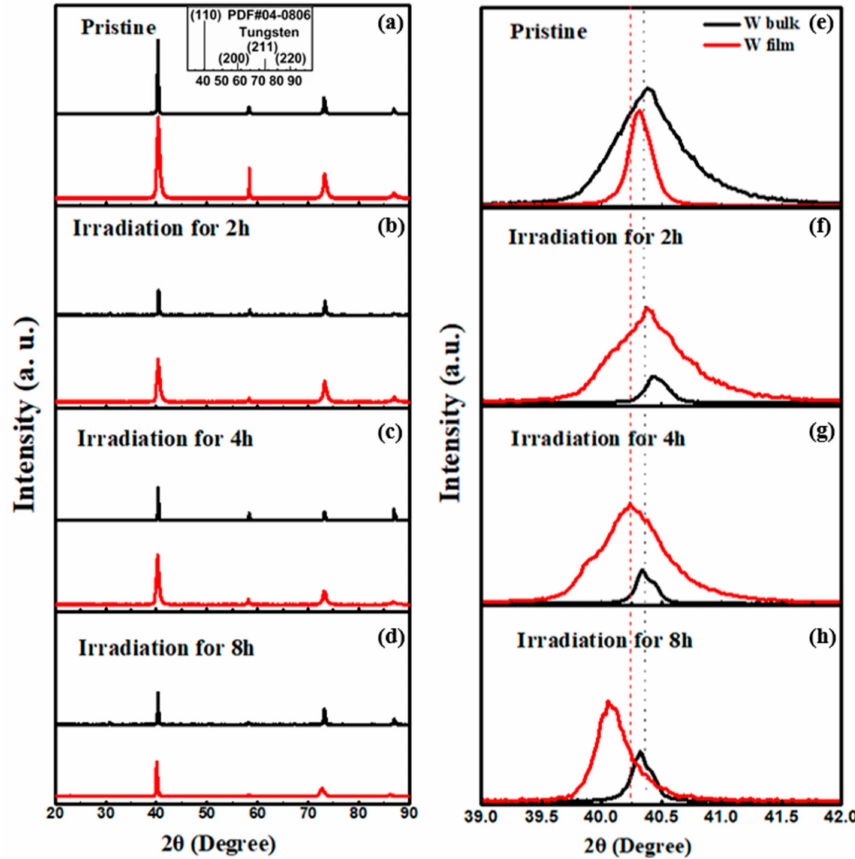
Figure 1. Pre- and post-deuterium irradiation X-ray diffraction (XRD) scans for W bulks and nanocrys- talline W